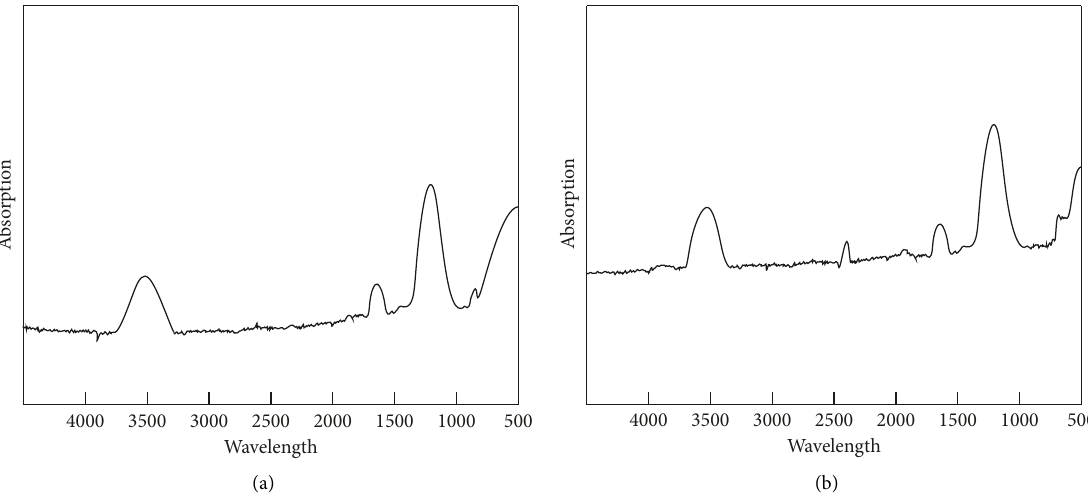
Figure 7: Infrared spectra of HGB before and after KH550 treatment. (a) The infrared spectrum of HGB without KH550 treatment. (b) The infrared spectrum of HGB after KH550 treatment.